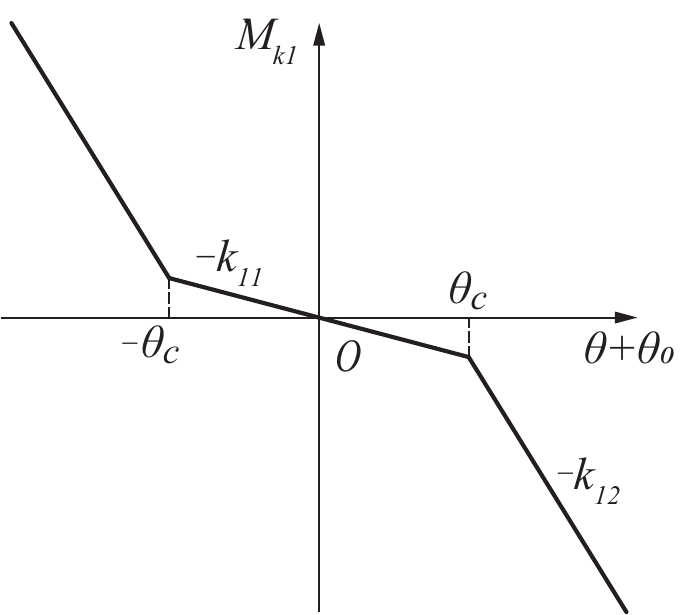
Figure 3. Restoring moment of the first link. k 11 and k 12 are the rotation stiffness of the shoulder with or without head contact, respectively. θ c is the angle at which the shoulder begins to contact the